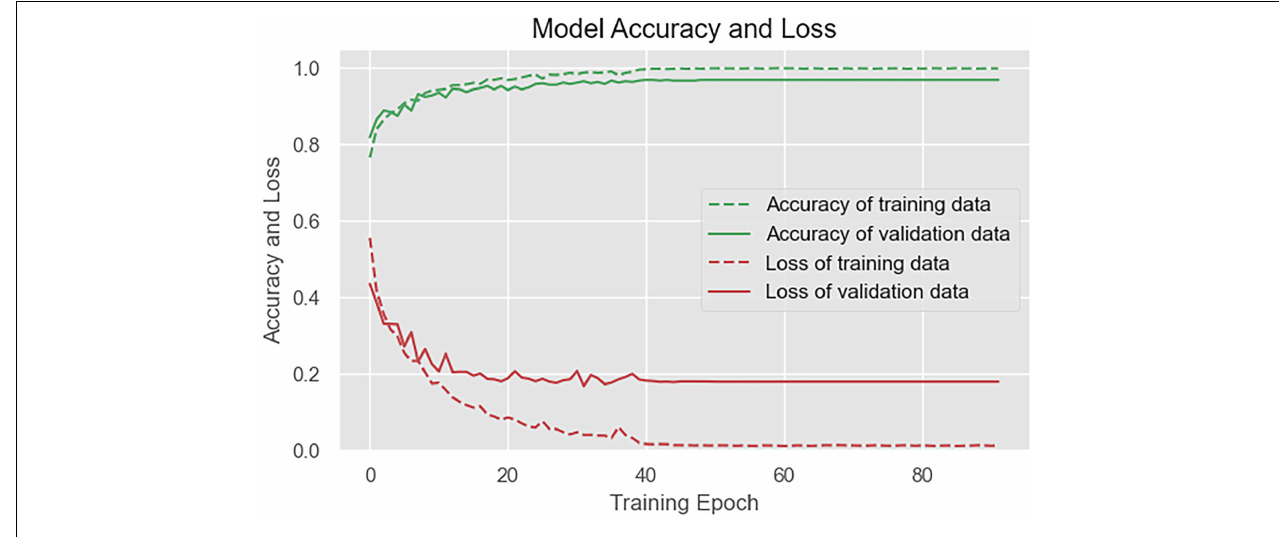
FIGURE 10 | Loss and accuracy of the model on the training set and the verification set.